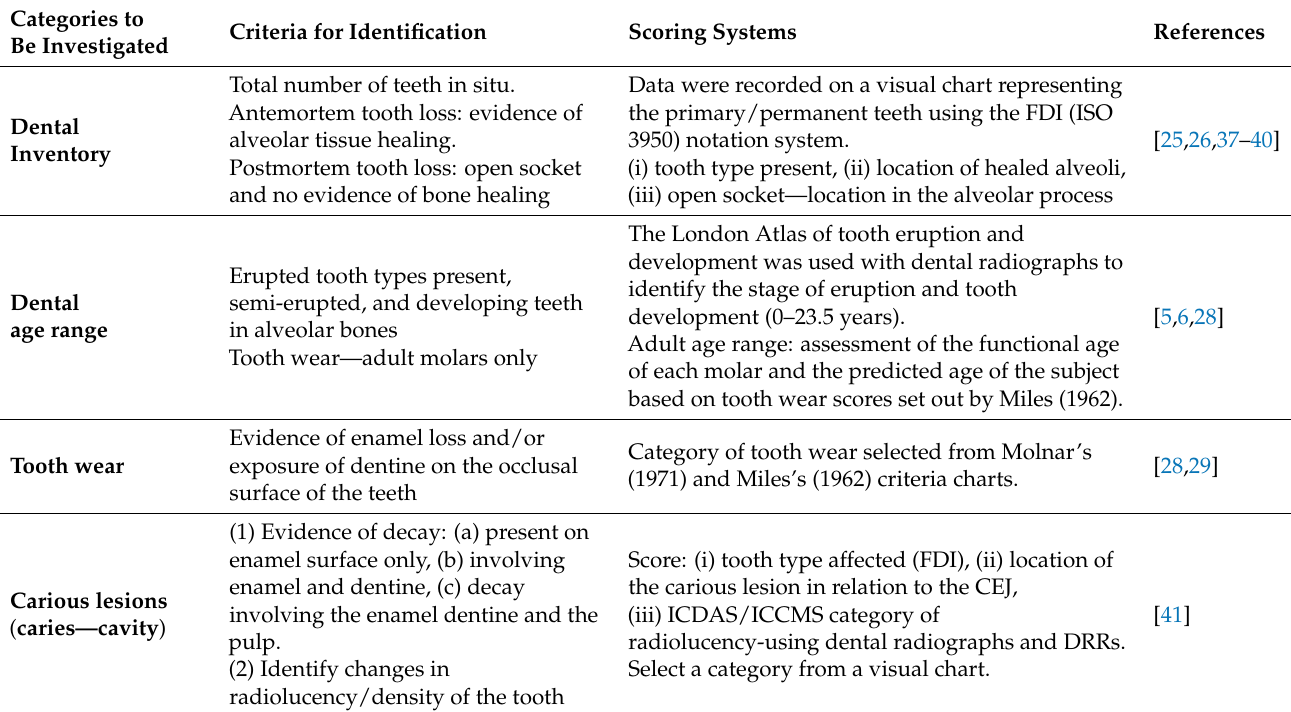
Table 1. Categories for scoring dental and alveolar bone